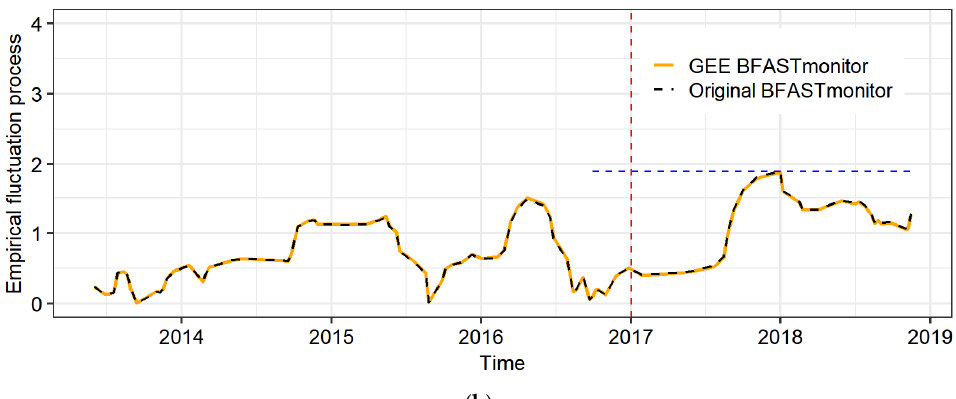
Figure 8. Absolute empirical fluctuation process for the ordinary least squares based moving sum (OLS-MOSUM) of residuals computed in R and GEE for ( a ) a pixel where both R (original BFASTmonitor) and GEE (GEE BFASTmonitor) implementations detected forest disturbance and ( b ) for a pixel where only R implementation detected forest disturbance at a Miombo woodland (Mozambican site).The vertical dashed line (red) denotes the start of the monitoring period, whereas the horizontal dashed line is the critical boundary. A breakpoint is signalled if the empirical fluctuation process crosses the critical boundary.